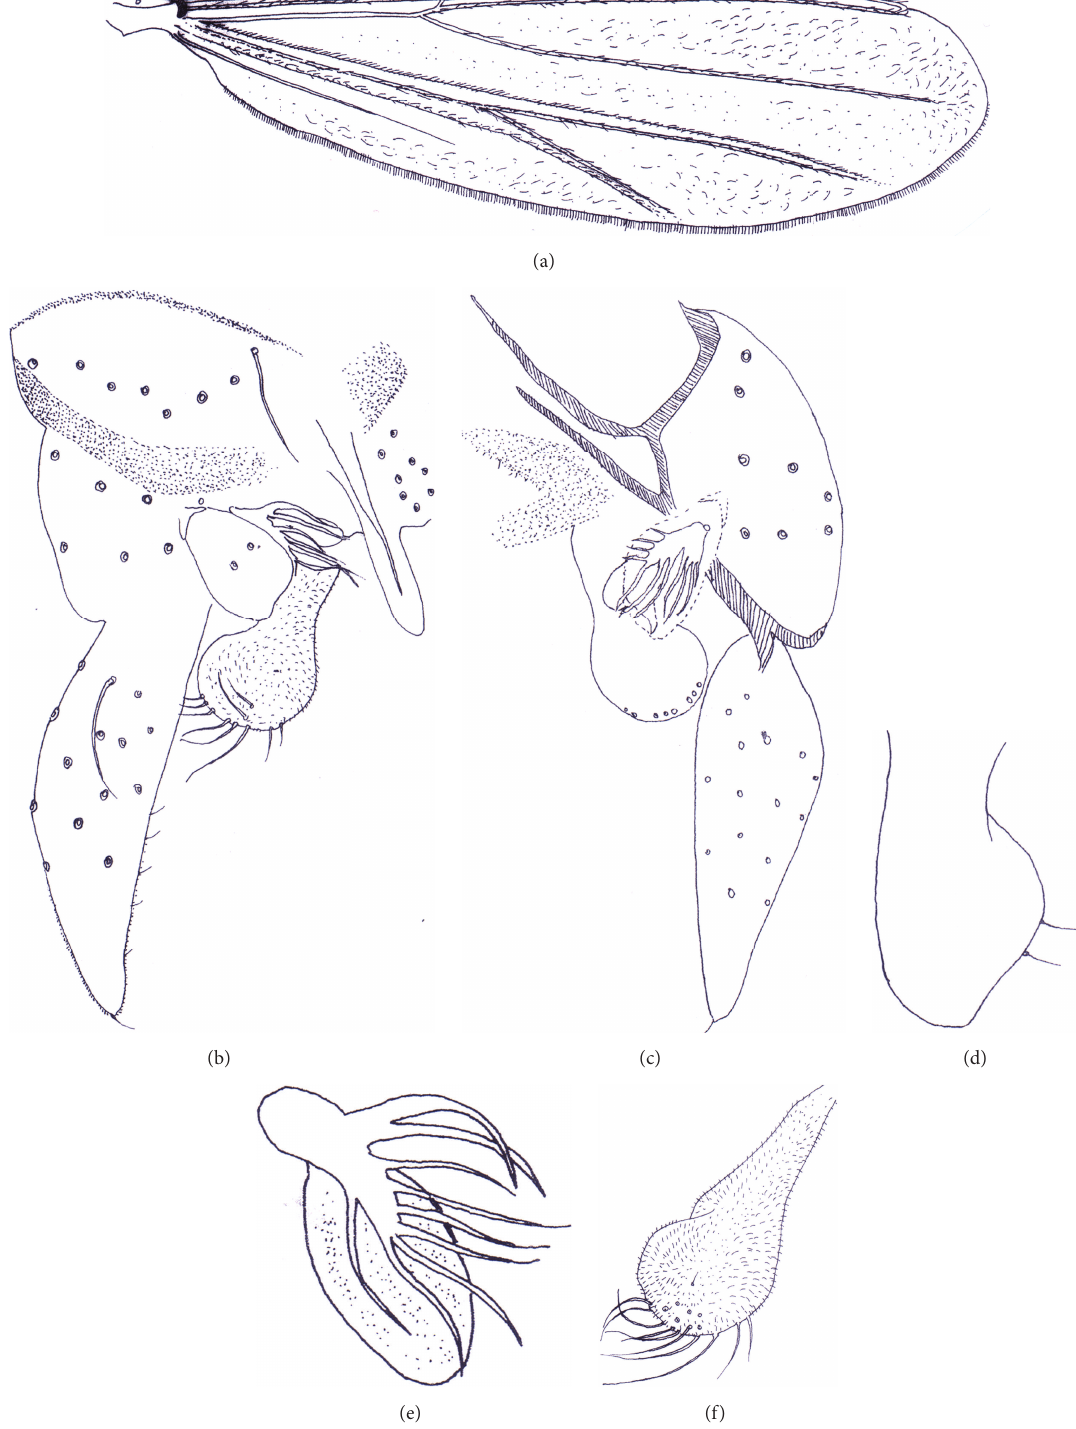
Figure 1: Rheotanytarsus nudicornus n. sp., adult male: (a) wing; (b) hypopygium (left-dorsal view); (c) hypopygium (right-ventral view); (d) superior volsella; (e) median volsella; and (f) inferior